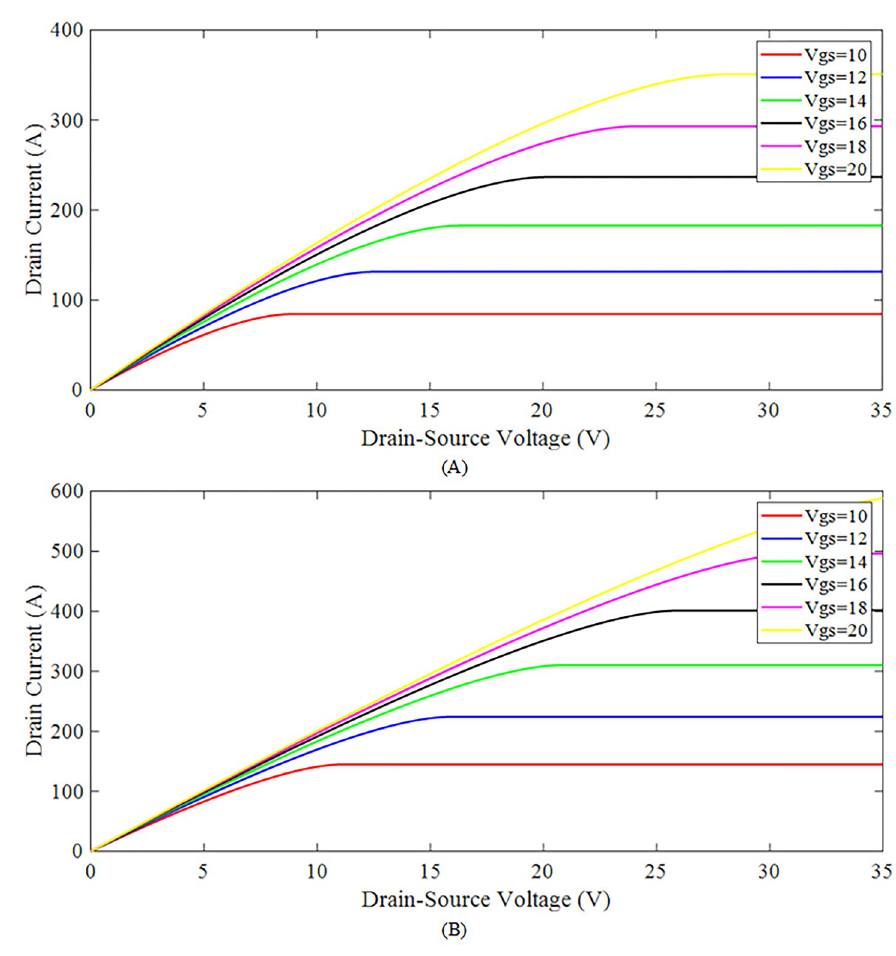
Fig 9. Sic nmos output transfer characteristics of the proposed model (A) at 25˚ C (B) at 150˚ C .